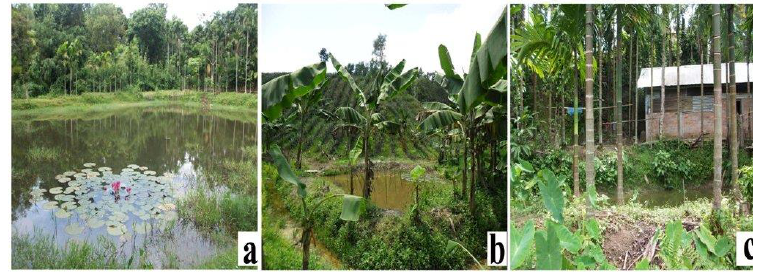
Figure 5. Rainwater harvesting through digging pond by the indigenous communities.